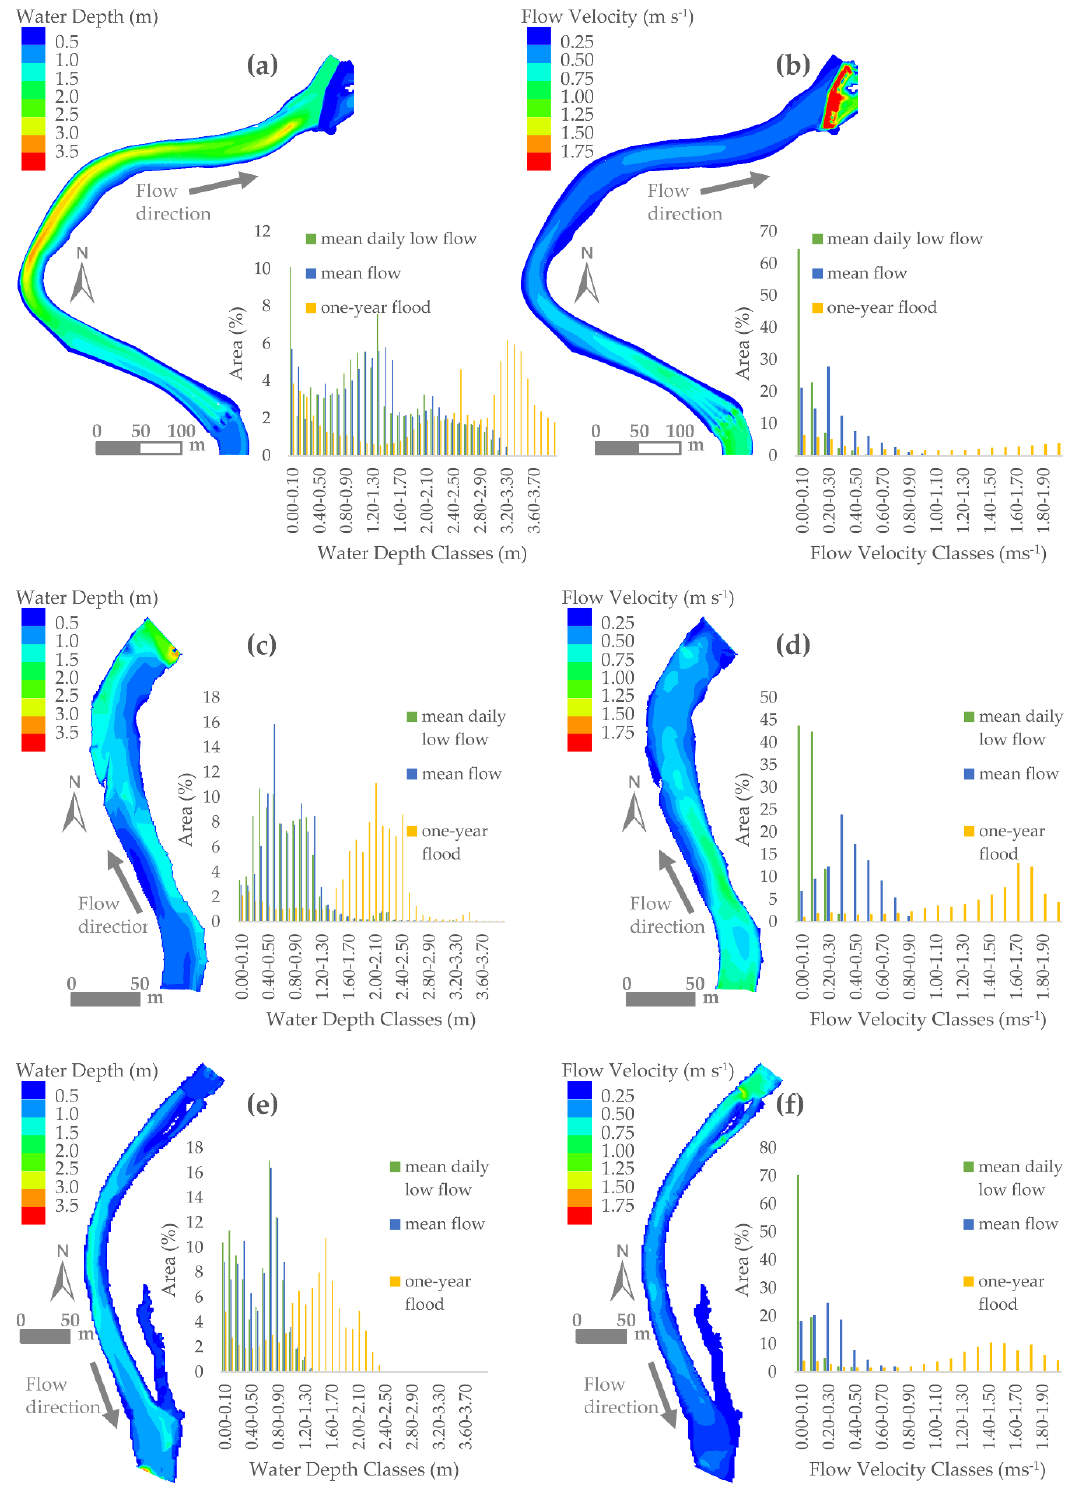
Figure 5. Results of the hydrodynamic simulations for investigated river stretches C.1 ( a ), ( b ), C.2 ( c ), ( d ), C.3 ( e ), ( f ). Shown are water depths ( a ), ( c ), ( e ) and flow velocities ( b ), ( d ), ( f ) at mean flow conditions. Inset: class distributions for the three calculated discharges (Q L , Q M , Q H ). Table 5. Summary of mean values ( 𝑥̅ ) and related standard deviations (σ) of water depths (m) and flow velocities (m s − 1 ).